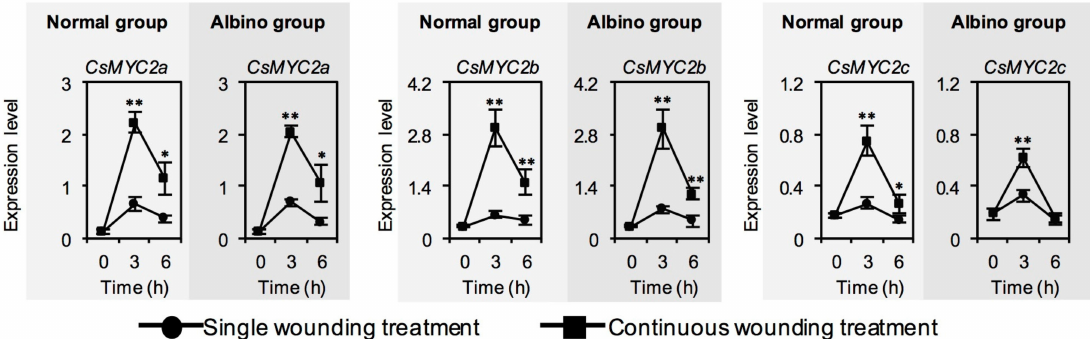
Figure 5. Changes in expression level of CsMYC2 , a key transcription factor of jasmonic acid (JA), of normal tea leaves and albino tea leaves exposed to single wounding treatment and continuous wounding treatment, respectively. Data are expressed as mean ± SD ( n =3). * p ≤ 0.05; ** p ≤ 0.01, comparison between single wounding treatment and continuous wounding treatment at the same treatment